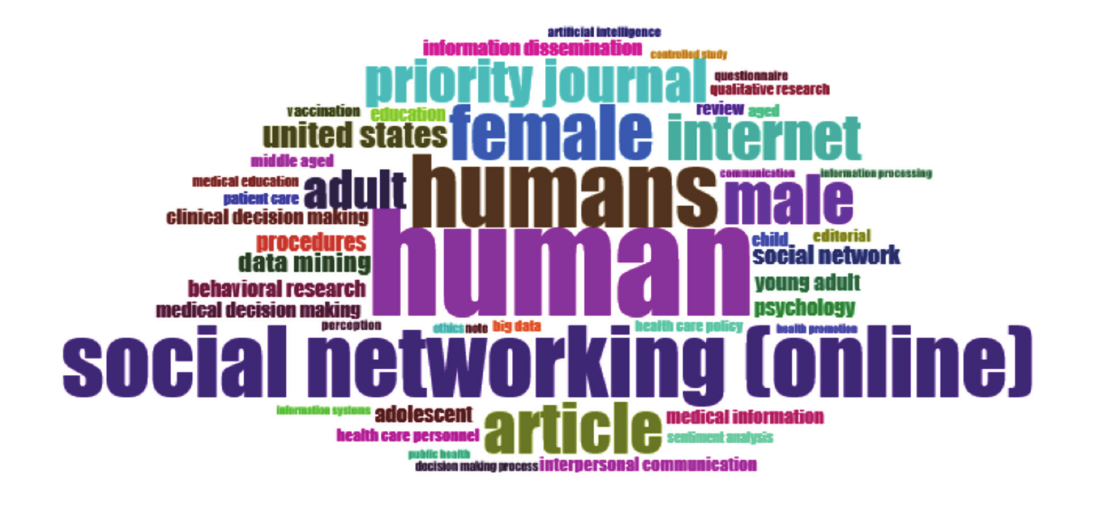
Fig. 9. Highest number of repetitive words in articles